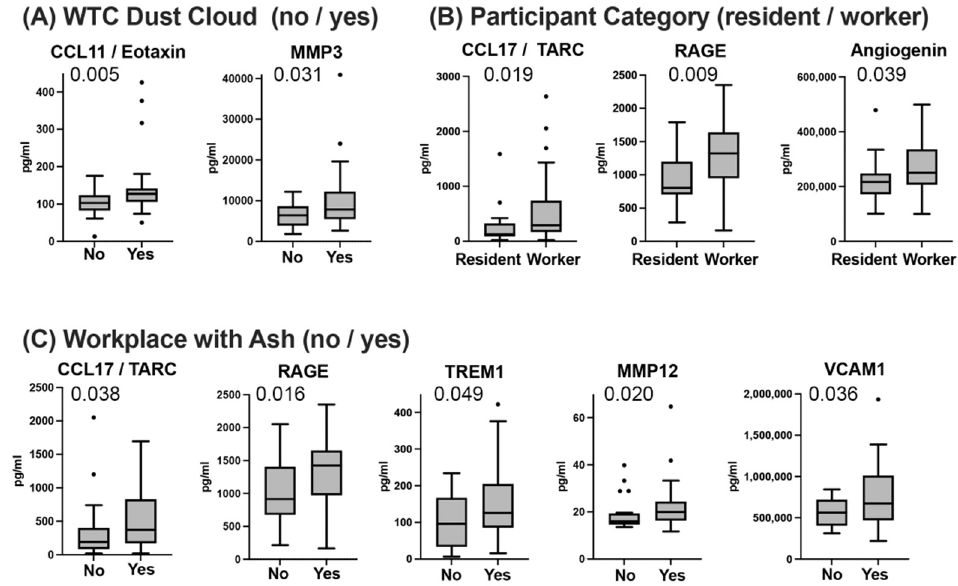
Figure 4 . Comparison of WTC exposure variables with respect to biomarker analytes. ( A ) WTC Dust Cloud at September 11, 2001 (9/11), no: n = 36, yes: n = 37; ( B ) participant category, residents: n = 16, workers: n = 57; ( C ) workplace with Ash, no: n = 20 – 21, yes: n = 30 – 37. The box plots were drawn according to Tukey, biomarkers that were significantly different between groups are shown. p -values were calculated with the independent, two-tailed Mann–Whitney test. Age, BMI, gender, or race/ethnicity were not different between groups defined by exposure categories (Supplemental Table S3).